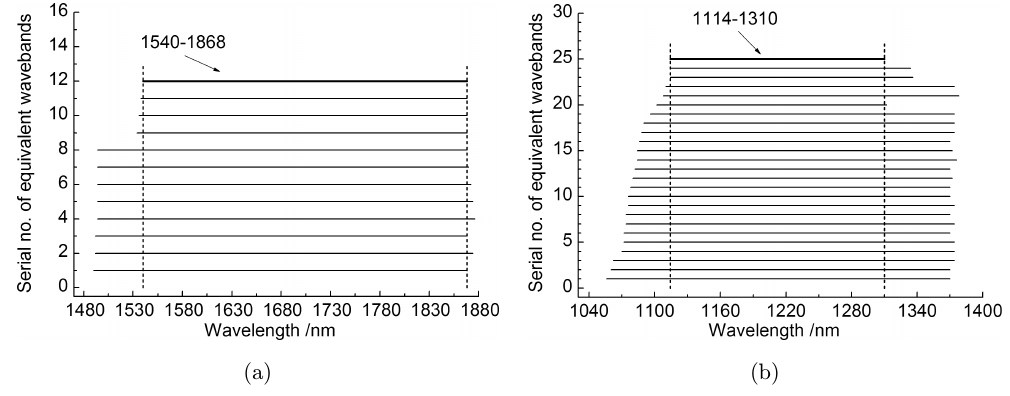
Fig. 10. Positions of equivalent wavebands for (a) TCP and (b) Table 5. Parameter selection and prediction e®ects of the equivalent public wavebands for TCP and Tris.